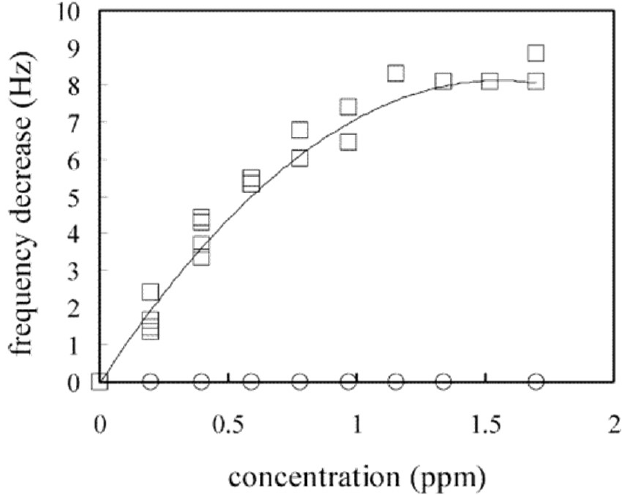
Figure 9. QCM response to menthol imprinted polymer films (squares) and non-imprinted controls produced with the same monomers (circles). The results shown were produced using a template, monomer (methacrylic acid), crosslinker (ethylene glycol dimethacrylate), solvent (chloroform) ratio of 1:4:20:50. Following polymerization the MIP was cast on a quartz crystal and measured gravimetrically. Reproduced with permission [172].